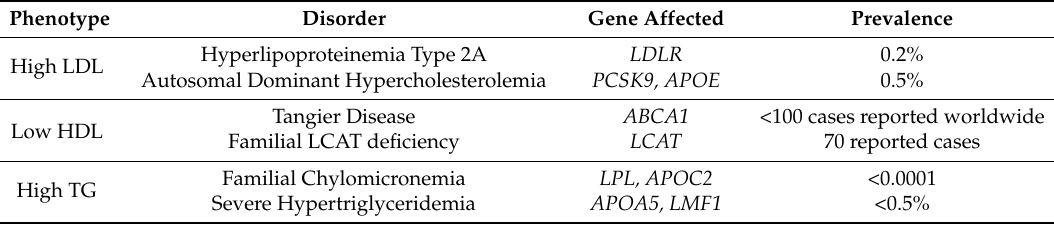
Table 1. Monogenic disorders affect blood lipid concentrations (not an extensive list).